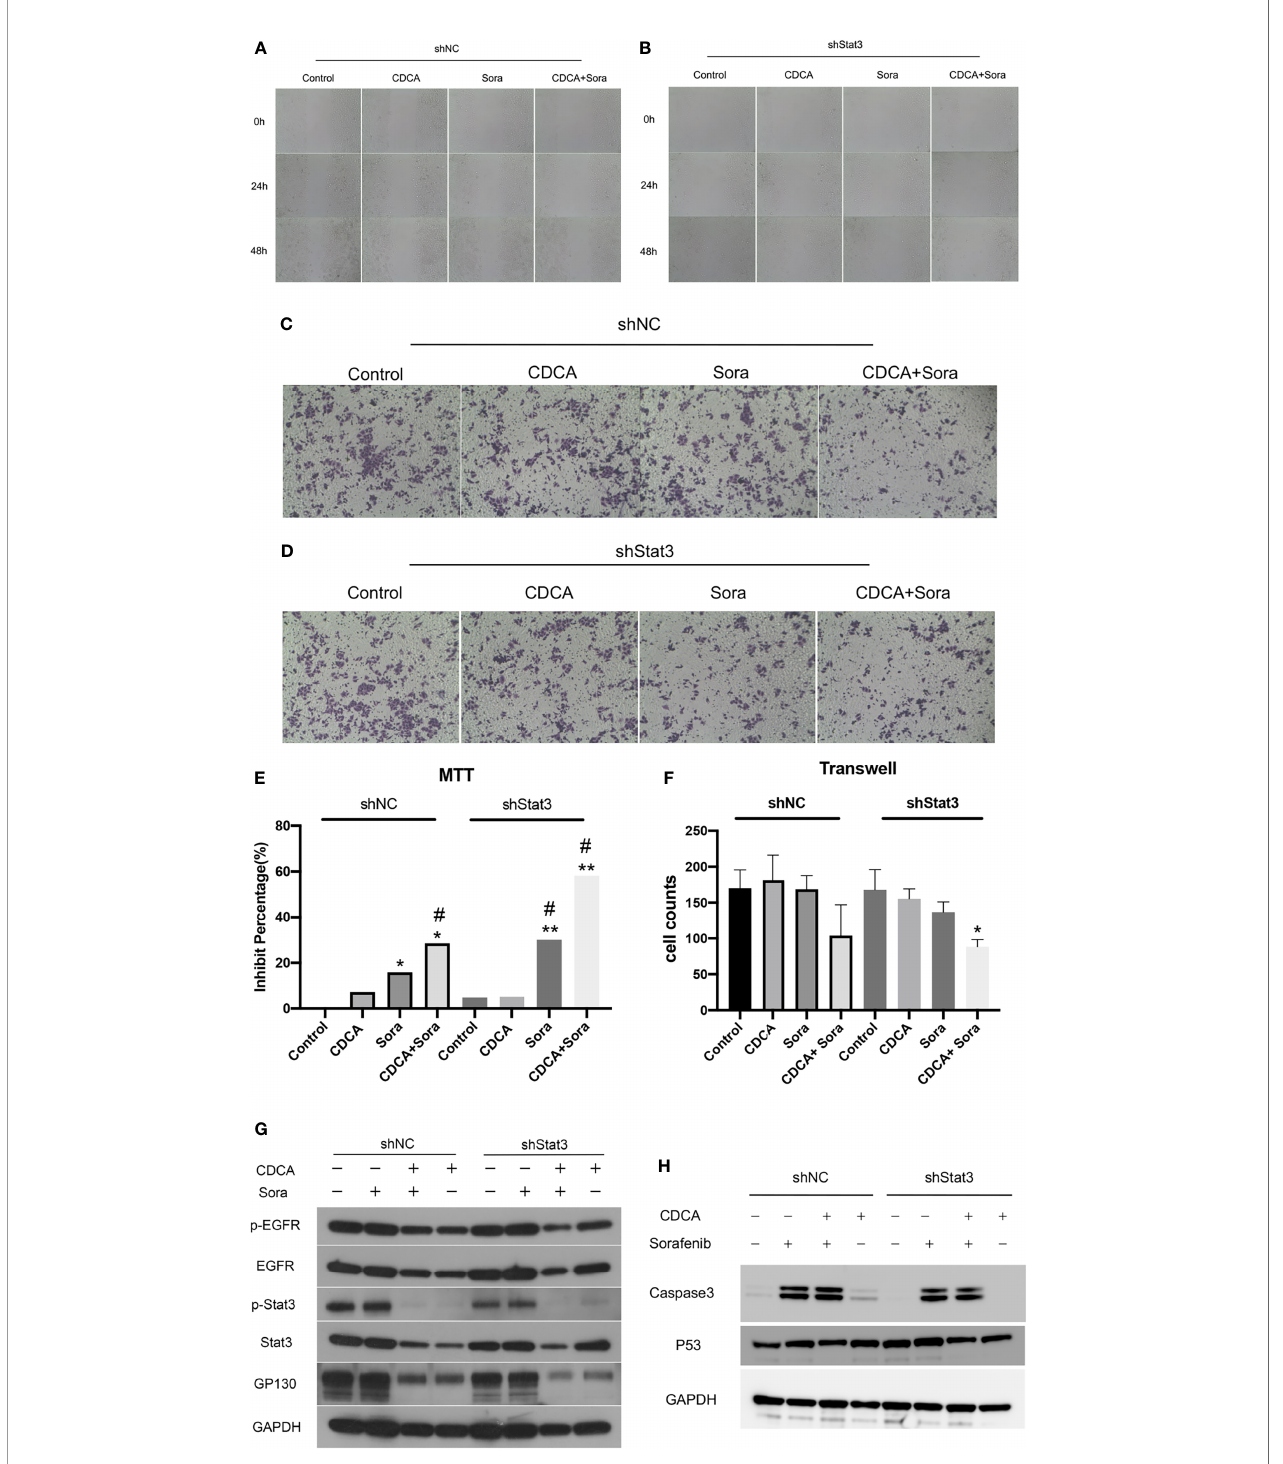
FIGURE 4 | In vitro validation of the effect of CDCA on Stat3. After knockdown of cellular Stat3, intervention with the same dose of CDCA and sorafenib as before. (A, B) Results of cell scratch experiments before and after Stat3 knockdown at 0, 24, and 48 h (10x). (C, D) Crystalline violet staining to observe cell proliferation before and after Stat3 knockdown (20x). (E) MTT results. * P < 0.05 vs. shNC-Control, ** P < 0.01 vs. shNC-Control, # P < 0.05 vs. shStat3-Control. (F) Transwell assay results. * P < 0.05 vs. shStat3-Control. (G) EGFR and STAT3 protein and phosphorylation levels before and after Stat3 knockdown. (H) Effect of CDCA on apoptotic protein caspase 3 and p53 expression before and after Stat3